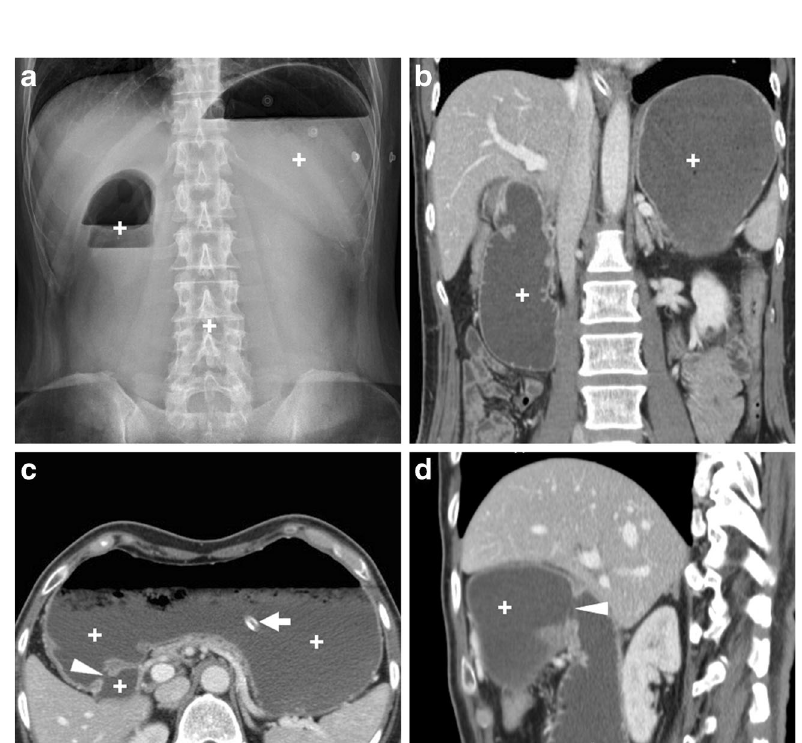
Fig. 14 A 31-year-old male with history of ileocecal resection for Crohn ’ s disease (CD) seven years earlier underwent CT- enterography with oral polyethylene glycol solution: the endoscopically diagnosed impassable stricture was well depicted between first and second duodenum (arrowheads in a , b ), and a second, longer cd lesion was seen the fourth duodenum (arrowheads in c , d ). Both strictures showed characteristic mural stratification and enhancing mucosa (thin arrows) of active CD